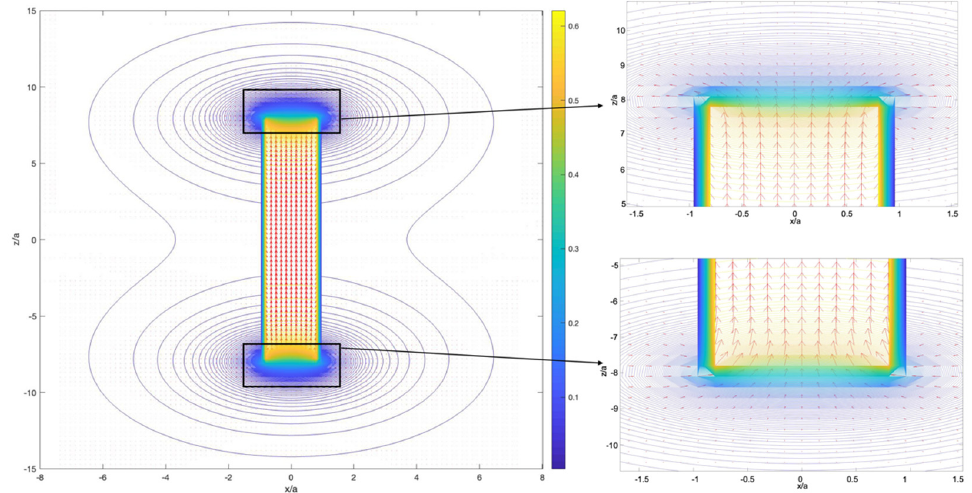
Figure 2. Magnetic induction configuration around a ferromagnetic cylinder with axial magnetisation. The calculations were performed for the following parameters: magnetisation M = 5 · 10 5 A/m (Co-based alloys), cylinder radius a = 15 µ m, and length 2 L = 16 a . Colour scale shows the magnitude of | B | in T